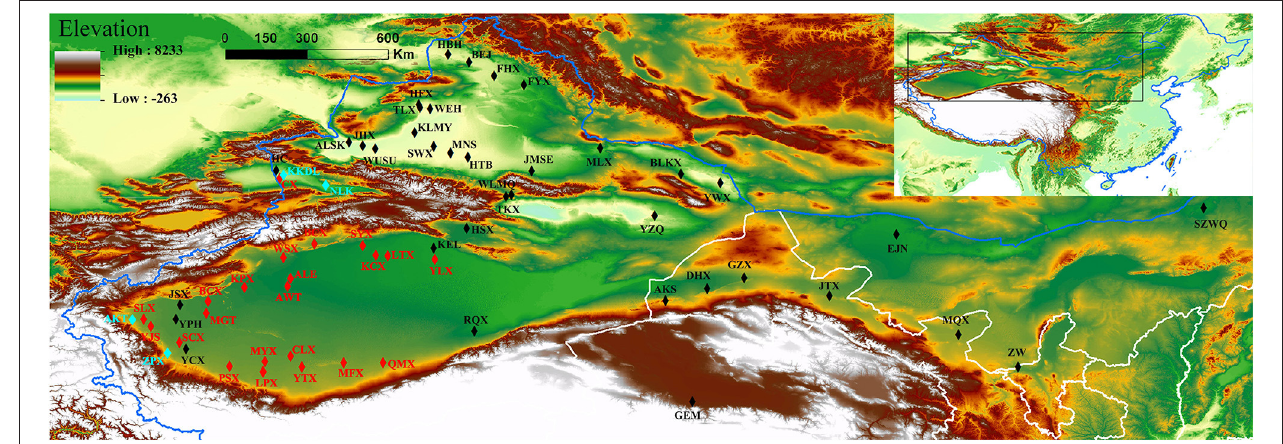
FIGURE 1 | Geographical distributions of the natural populations of P. euphratica and P. pruinosa analyzed in this study. Different font colors represent the two species: black for P. euphratica populations, light blue for P. pruinosa populations, and red for overlapping populations. The map was created using the ArcMap package in ArcGIS ver. 10.8 (http://www.esri.com/software/arcgis). The populations are described in Supplementary Table 1